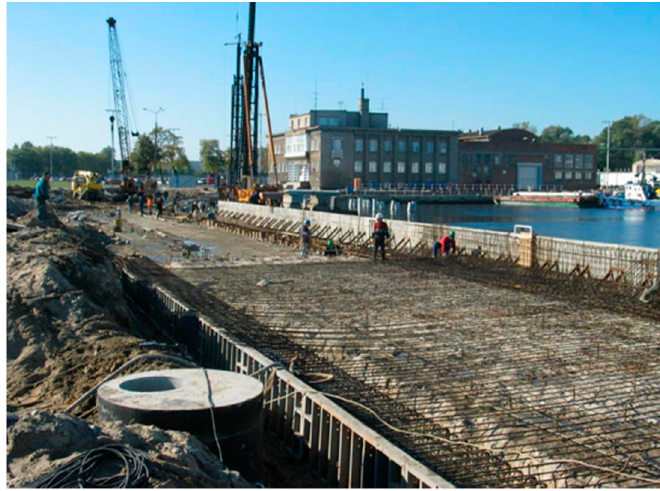
Figure 1. Pier made from steel ‐ reinforced concrete under construction.